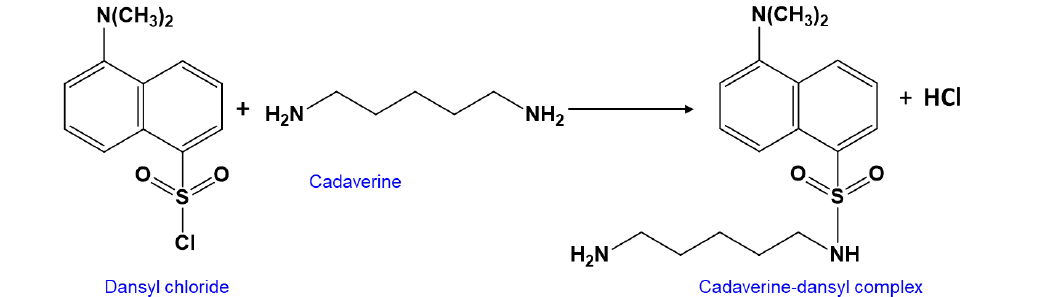
Figure 1: Dansyl chloride mediated derivatization of biogenic amine. Cadaverine was used as representative biogenic amine